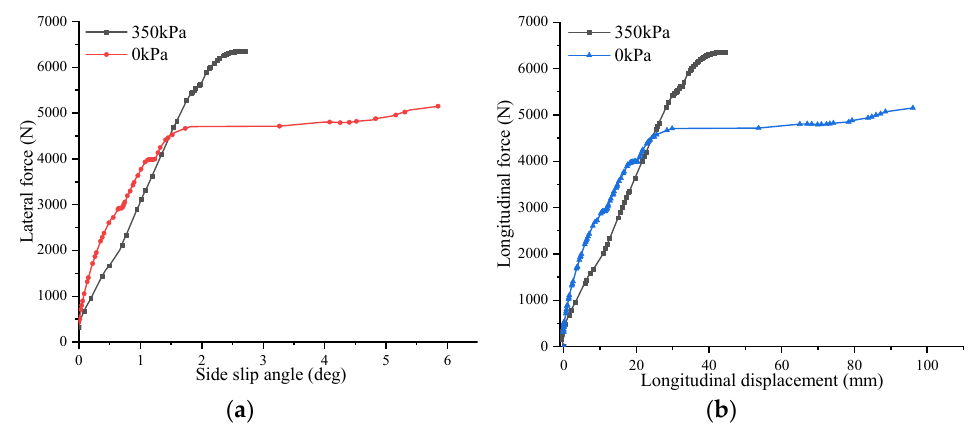
Figure 1. Curve of inserts supporting run-flat tire test results. ( a ) Cornering stiffness curve; ( b ) longitudinal stiffness curve.